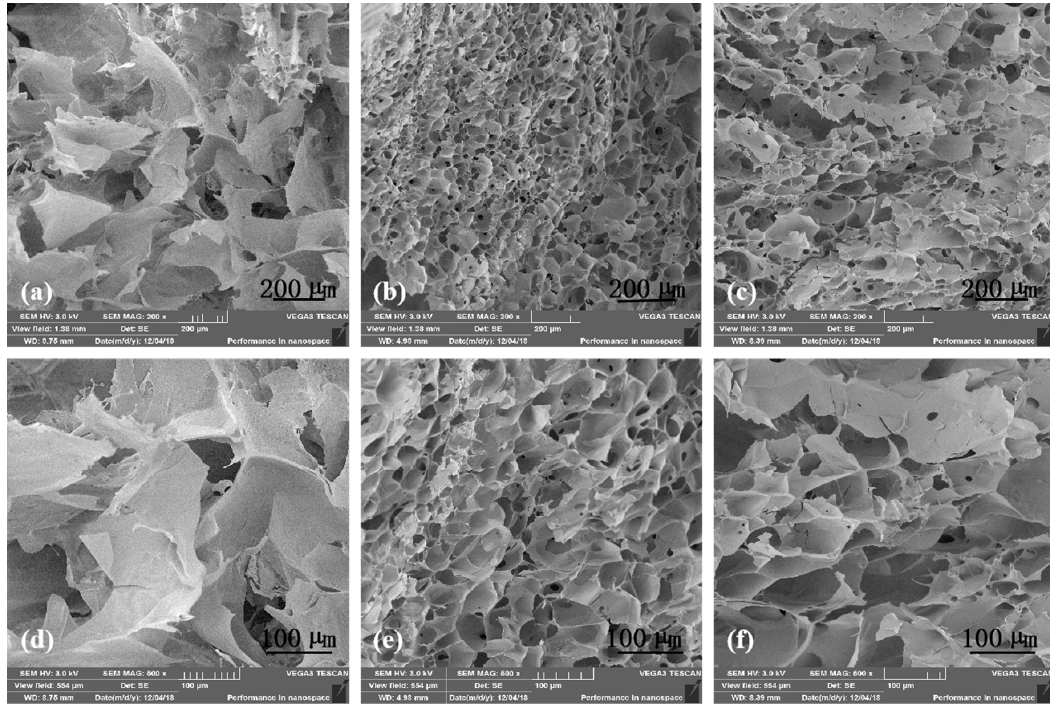
Figure 3. Scanning electron microscopy (SEM) micrographs of the alginate / gelatin hydrogels: ( a ) alginate-semi-interpenetrating polymer network (A-semi-IPN), ( b ) gelatin-semi-interpenetrating polymer network (G-semi-IPN), ( c ) alginate-gelatin-interpenetrating polymer network (A-G-IPN), ( d ) a magnified image of ( a , e ) a magnified image of ( b ), and ( f ) a magnified image of ( c ). 2.3. Water Holding Capacities (WHCs) of the A-G-IPN Hydrogels